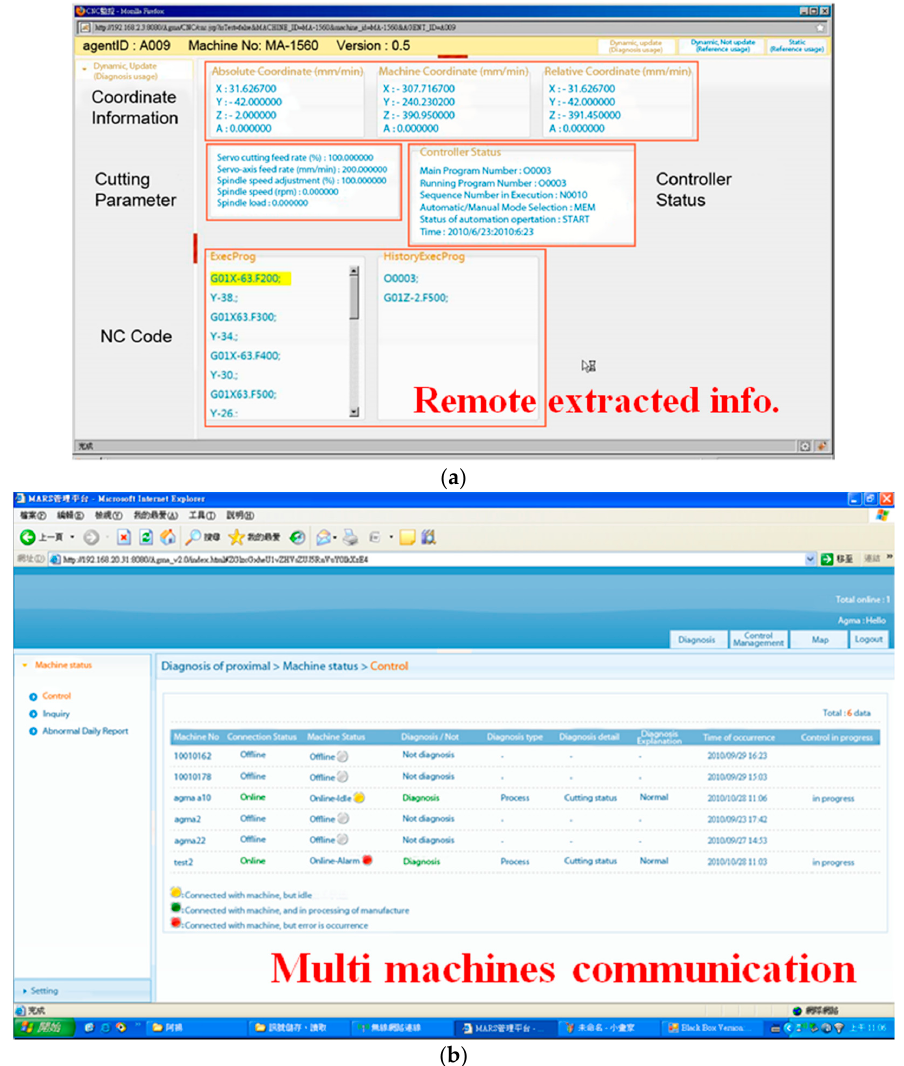
Figure 17. Bilateral communication module for computer numerical control (CNC) controller. ( a ) On ‐ line extracted information from CNC controller; ( b ) The module synchronously communicates with several machines.